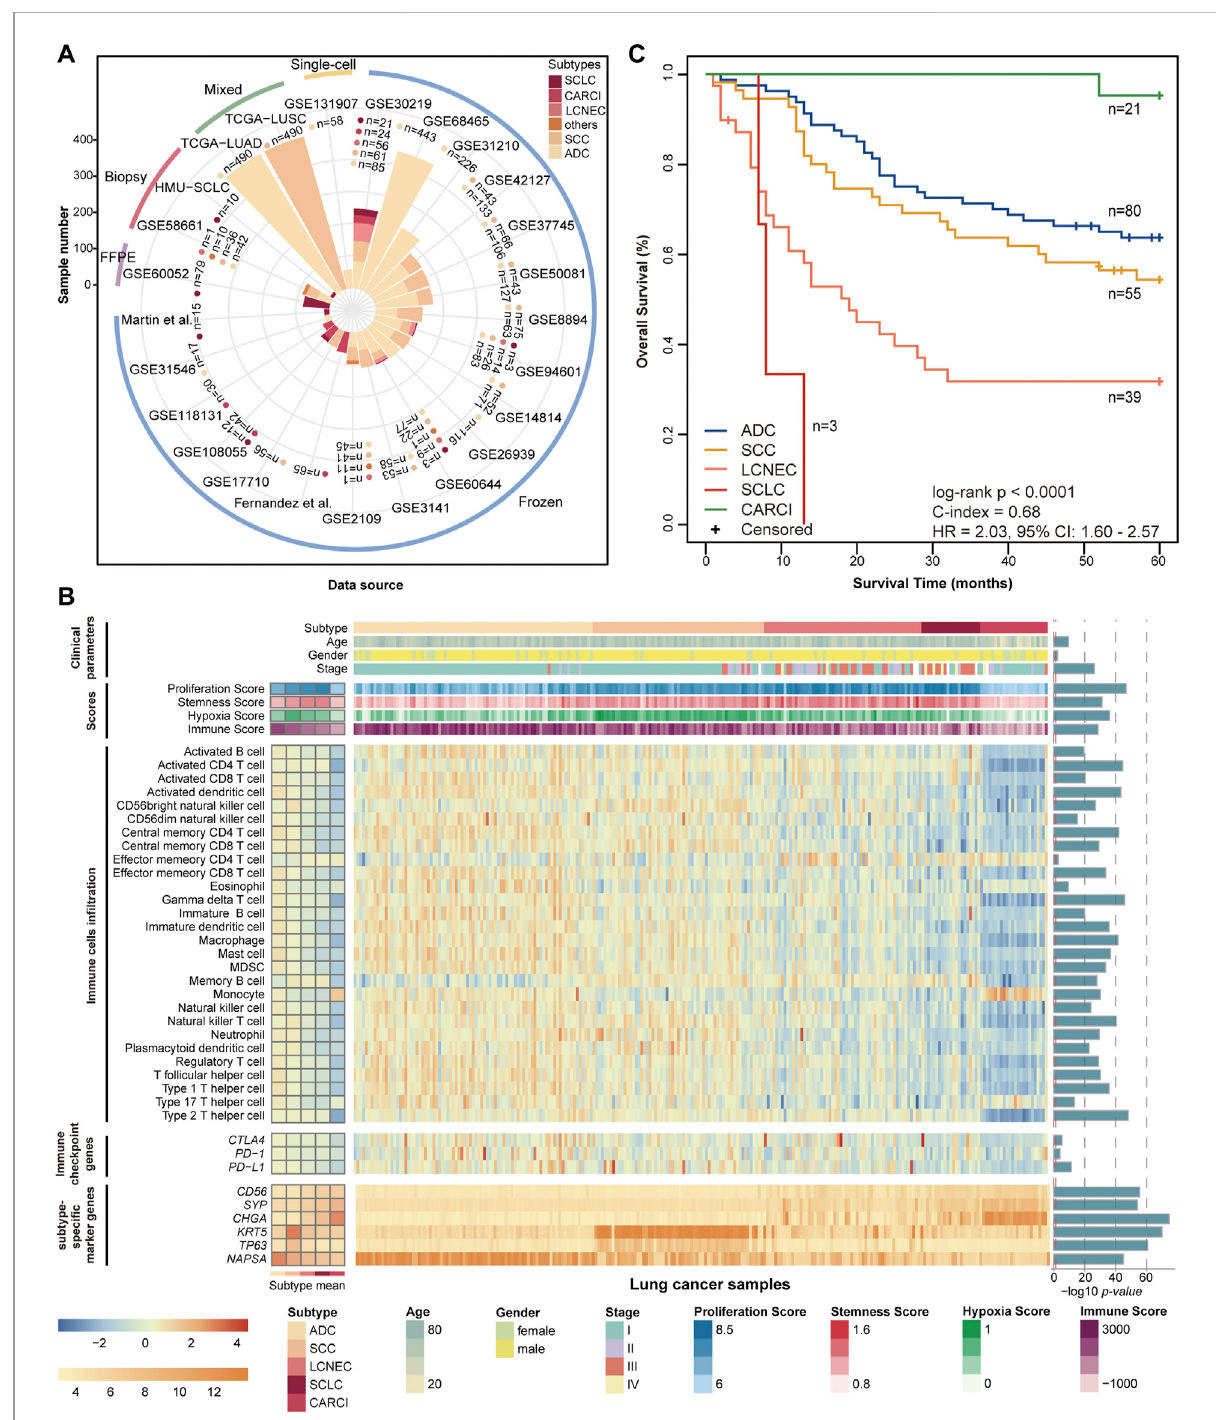
FIGURE 1 Datasets and molecularlandscapeof lung cancer. (A) 25 lung cancer datasets wereused inthis study. (B) heatmaps of the molecular landscape of lung cancer subtype in the training (GSE30219) dataset. The clinical heatmap panels show the distributions of clinical parameters, including histological subtype, tumor stage, age, and sex. The score heatmap panels show the proliferation scores, stemness scores, hypoxia scores, and immune scores calculated by mRNA expression pro fi les, based on the published articles (Supplementary Material). The boxplots of four scores acrossthelungcancersubtypesaredisplayedinSupplementaryFigureS1.Theimmunecellheatmappanelsshowtherelativein fi ltrationabundances of 28 immune cell types quanti fi ed by ssGSEA. The immune checkpoint heatmap panels show the mRNA expression levels of three immune checkpoint genes, which are targets of immunotherapy. The levels of immune cell in fi ltration and immune checkpoint gene expression were scaled